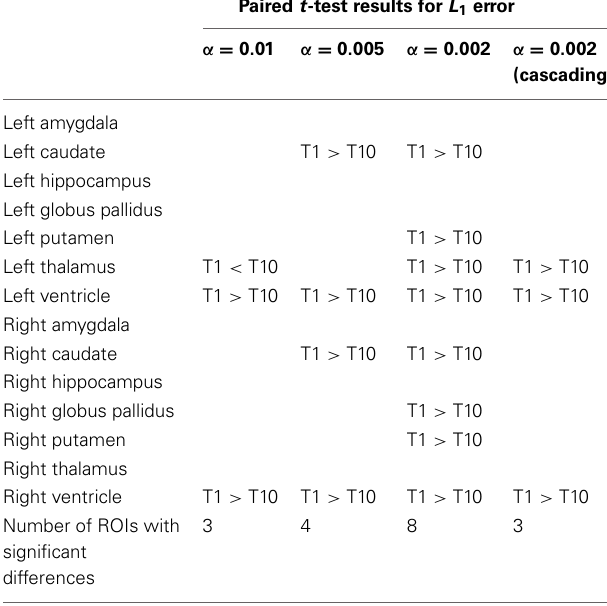
Table 1 | For each ROI and for each α in LDDMM, the L 1 error results for T = 1 and T = 10 were compared using one sided paired sample t -test. Paired t -test results for L 1 error